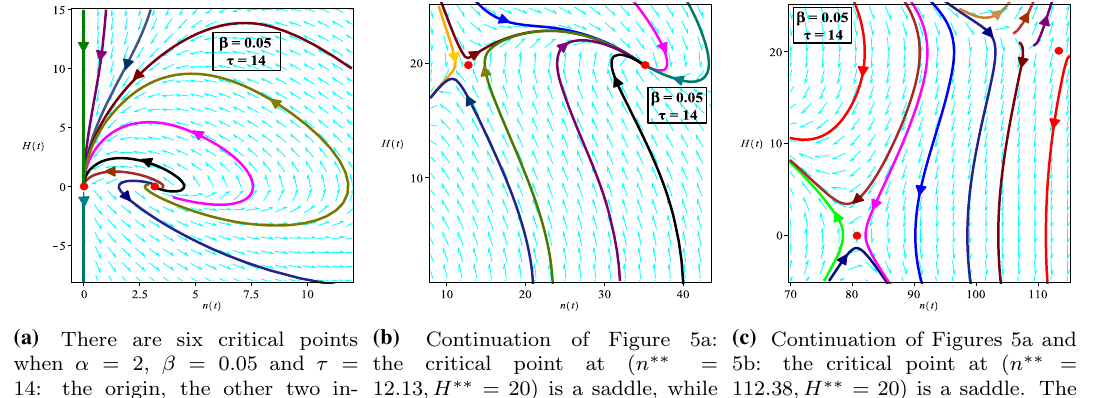
(b) Continuation of Figure 5a: the critical point at ( n ∗∗ = 12 . 13 , H ∗∗ = 20) is a saddle, while the one at ( n ∗∗ = 34 . 69 , H ∗∗ = 20) is a stable node.